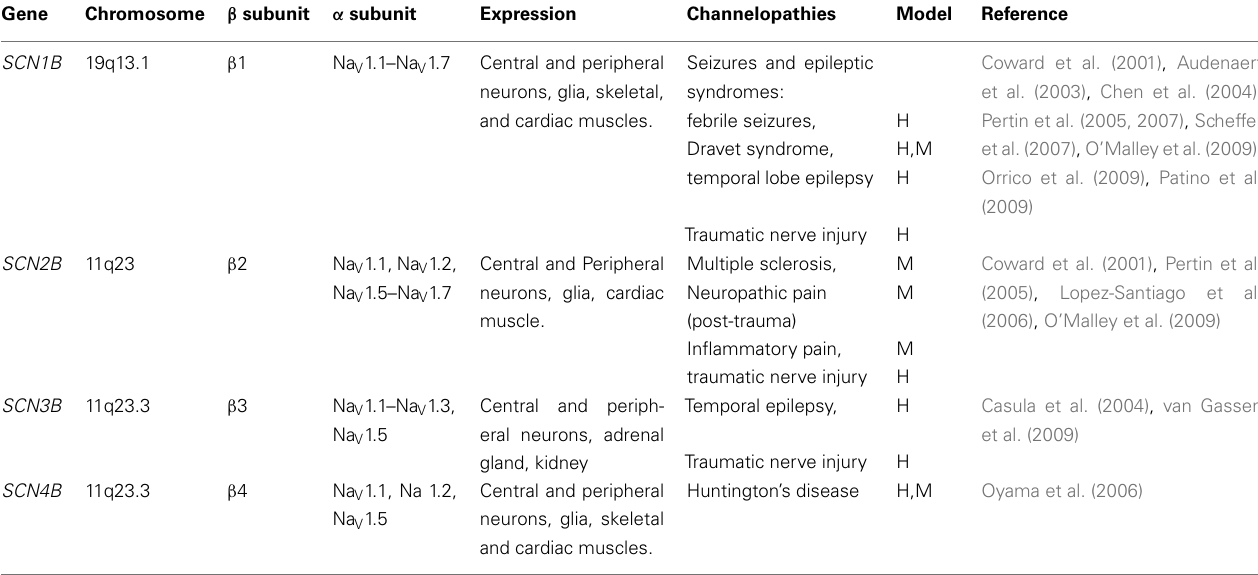
Table 2 | Summary of the different types of β subunits associated with the differentVGSC, and the related channelopathies associated with the mutations in the genes that encode them (modified from Patino and Isom,